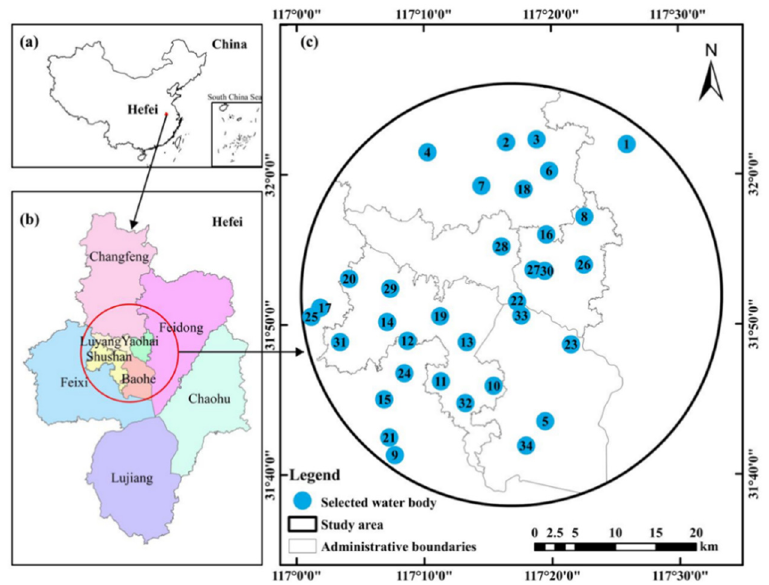
Figure 1. The study area. ( a ) Hefei, China; ( b ) administrative boundary of Hefei; ( c ) locations of selected water bodies in the study area.